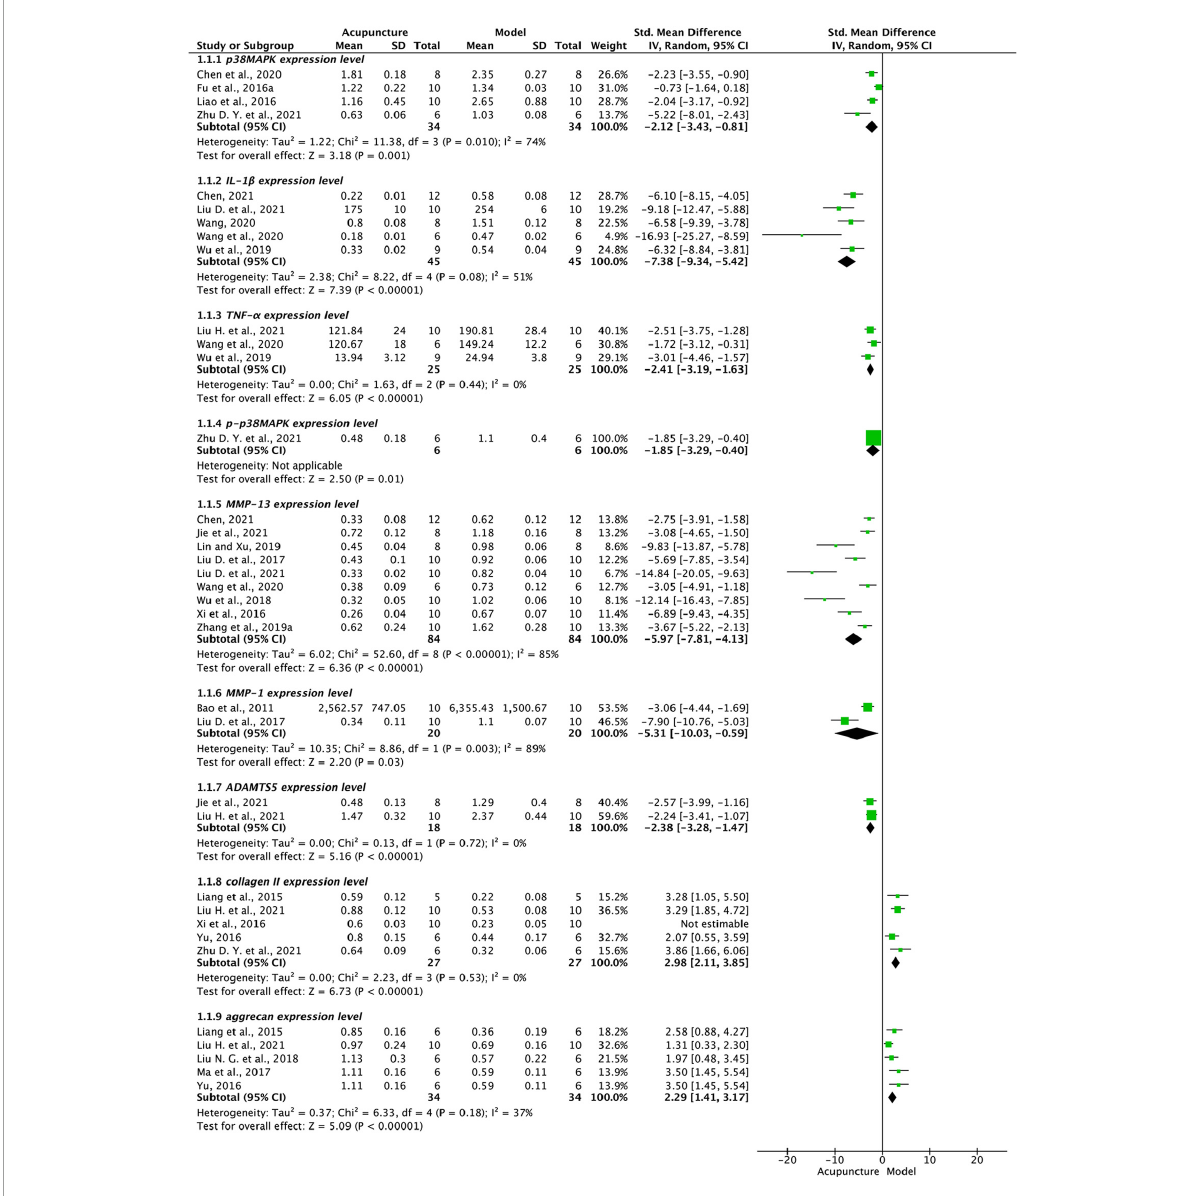
FIGURE2 Forest plot of p38MAPK signaling regulators. p38MAPK, IL-1 β , TNF- α , p-p38MAPK, MMP-13, MMP-1, ADAMST-5, collagen II, and aggrecan in acupuncture and model